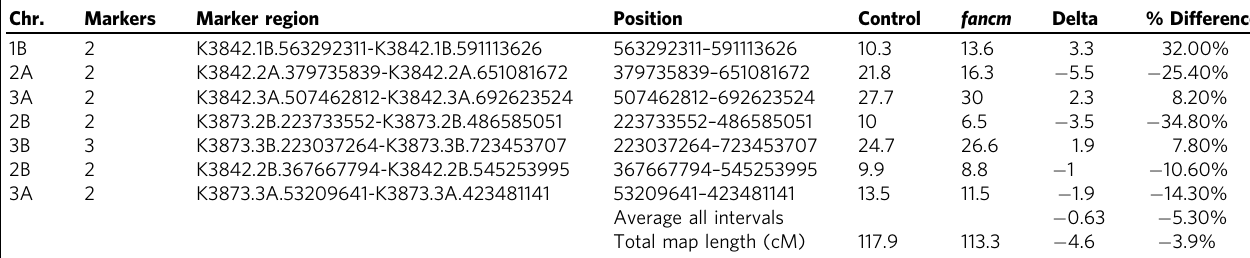
Table 2 Recombination analysis in the tetraploid Kronos F 3 fancm mutant mapping population.